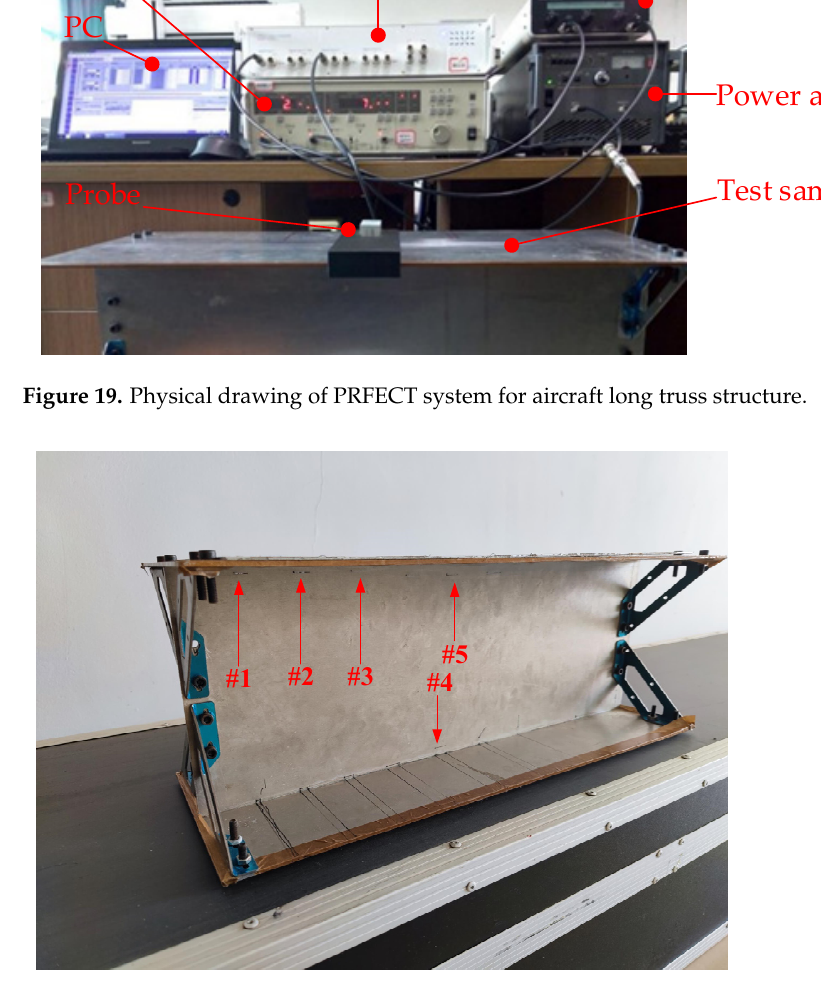
Figure 20. Test sample. (#1) 5 × 0.2 × 3 mm (Buried depth: 6 mm); (#2) 10 × 0.2 × 3 mm (Buried depth: 6 mm); (#3) 15 × 0.2 × 3 mm (Buried depth: 6 mm); (#4) 10 × 0.2 × 3 mm (Buried depth: 8 mm); (#5) 10 × 0.2 × 3 mm (Buried depth: 10 mm).